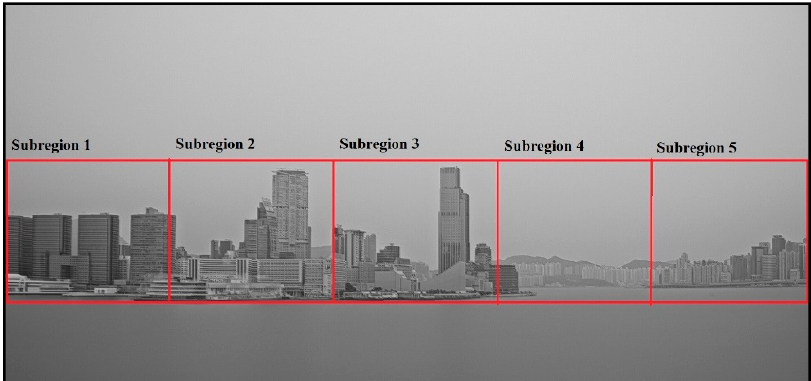
Figure 9. Subregion segmentation image.